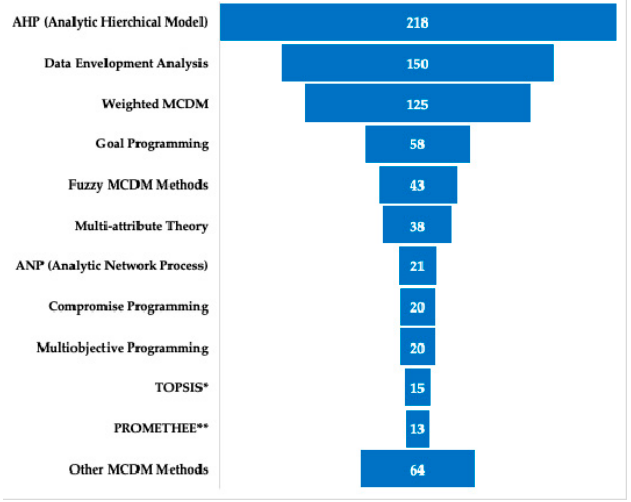
Figure 3. Frequency of multicriteria decision-making (MCDM) techniques. *TOPSIS: Technique for Order of Preference by Similarity to Ideal Solution; **PROMETHEE: Preference Ranking Organization Method for Enrichment Evaluations.